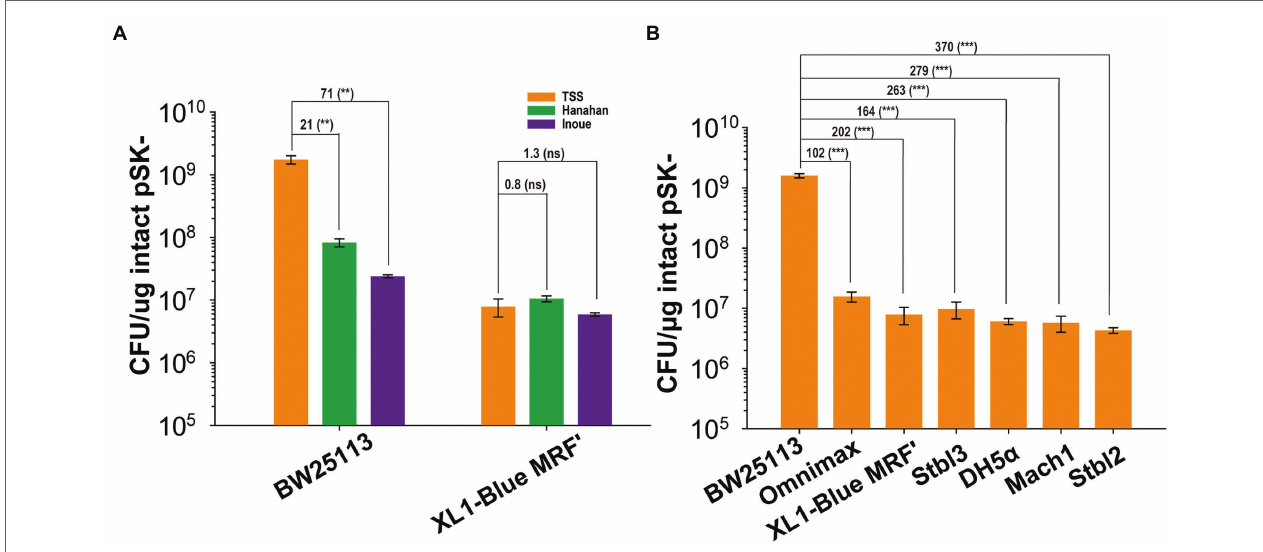
FIGURE 1 | The TEs of E. coli strains. (A) The TEs of competent cells prepared with three different methods for two E. coli strains. (B) The TEs of competent cells prepared with TSS for seven E. coli strains. BW25113, Omnimax, XL1-Blue MRF’, Stbl3, DH5 α , Mach1, and Stbl2. Data are averages of three samples with standard deviations (error bars). Unpaired t-tests were performed (** = p < 0.01; *** = p < 0.001; and “ns” = p > 0.05). “ns” means “not significant.” The numbers before (***) represent the difference by